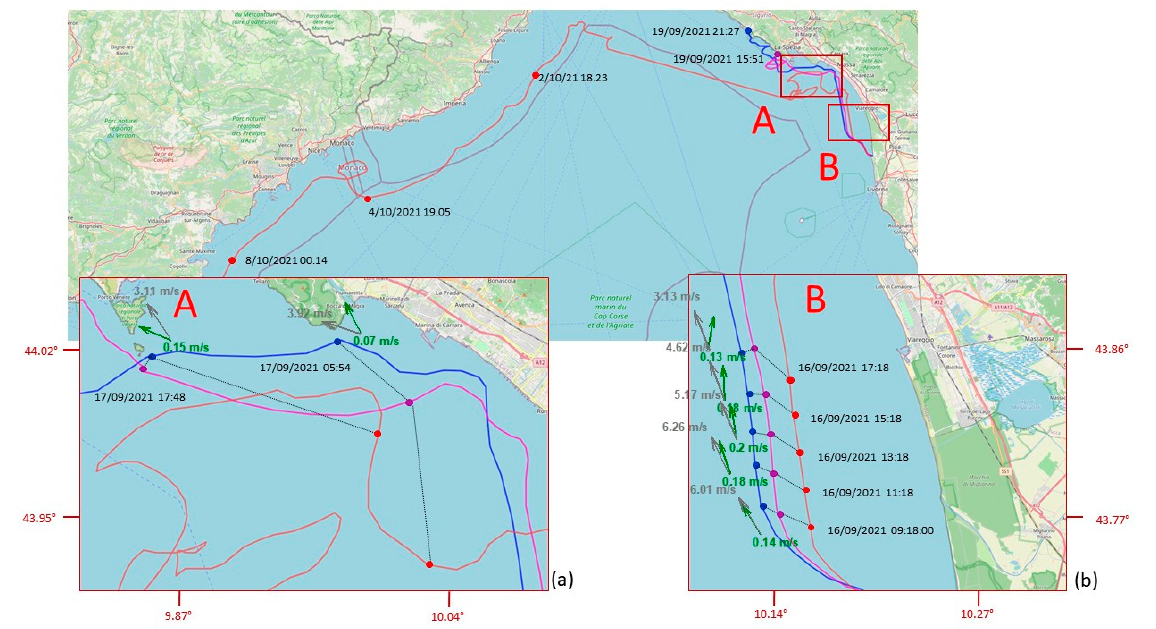
Figure 7. September 2021 launch with three MLT (time is expressed according to CEST). The drifters’ trajectories refer to L3T1 (blue line, bottle-shaped), L3T2 (violet line, bottle-shaped), L2T2 (red line, tablet-shaped), as reported in Table 1. Boxes ( a ) and ( b ) are zooms on the two coastal areas A and B highlighted in the full picture. The green and gray arrows in panels A and B represent current and wind direction, respectively. The associated intensities are reported aside with the same colors. The green arrows indicate wind intensity and direction, the gray arrows for surface current intensity and direction.